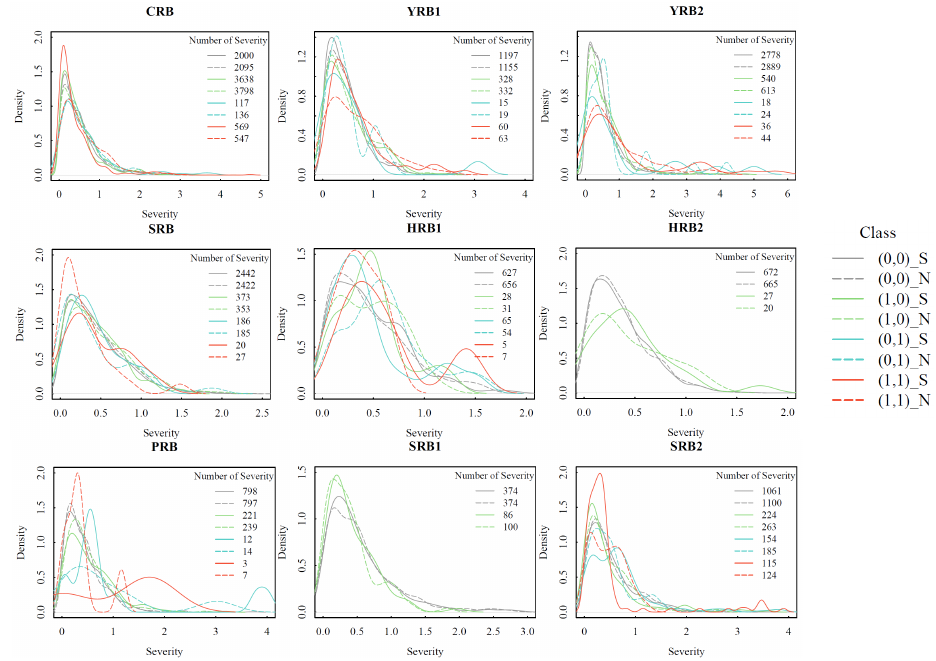
Figure 7. Probability density of severity estimated by SPEI and NSPEI in the nine river basins of China under different classifications of ( μ , σ ) changes in the spring–summer season.